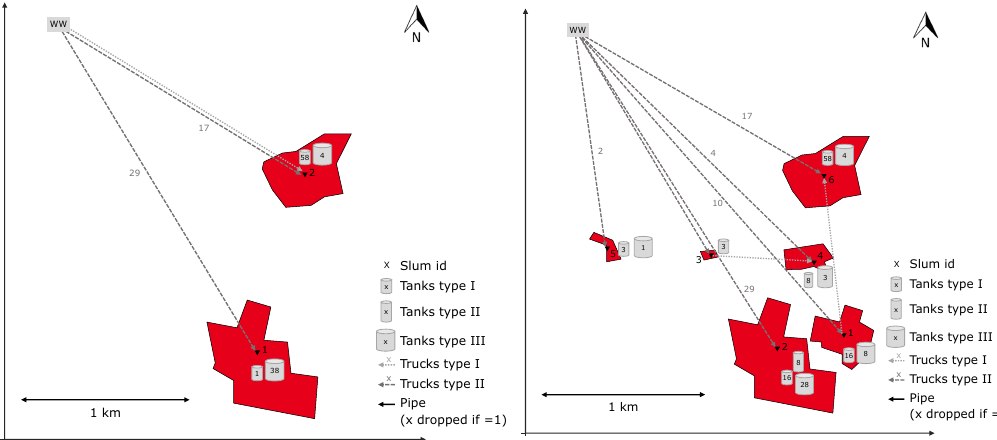
Figure 11. Optimization result for a slum cluster in Dar es Salam, Tanzania, in 1998 (left) and in 2002